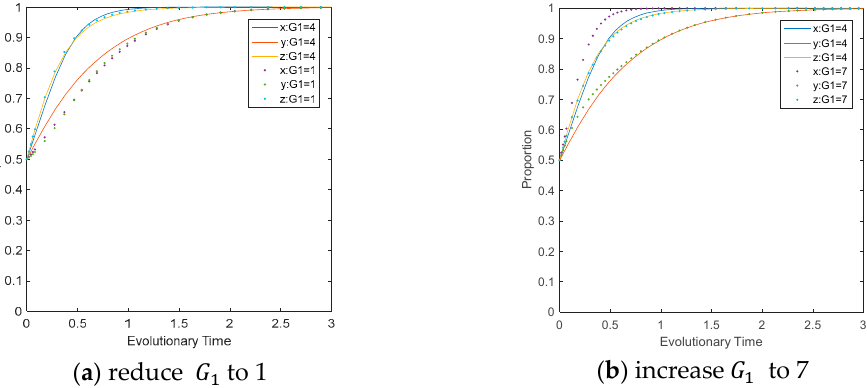
Figure 9. Impact of G 1 on the evolutionary path of multi-agents.